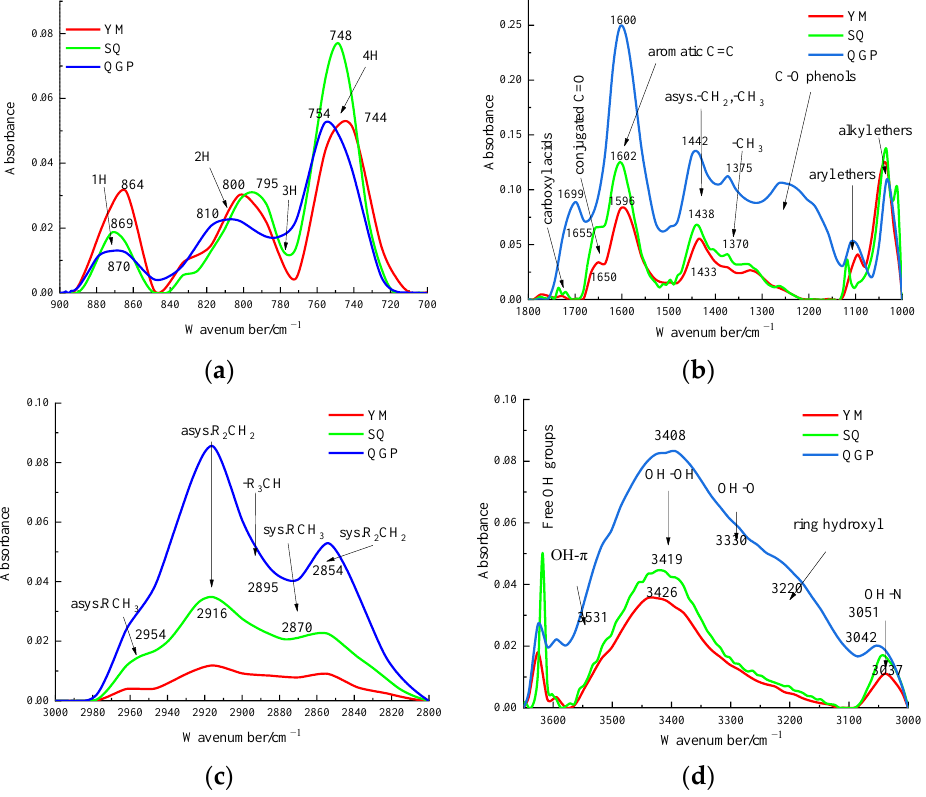
Figure 1. FTIR spectra of different coal ranks. ( a ) Aromatic hydrocarbon; ( b ) Oxygen-containing functional group; ( c ) Aliphatic structure; ( d ) Hydroxyl functional group.